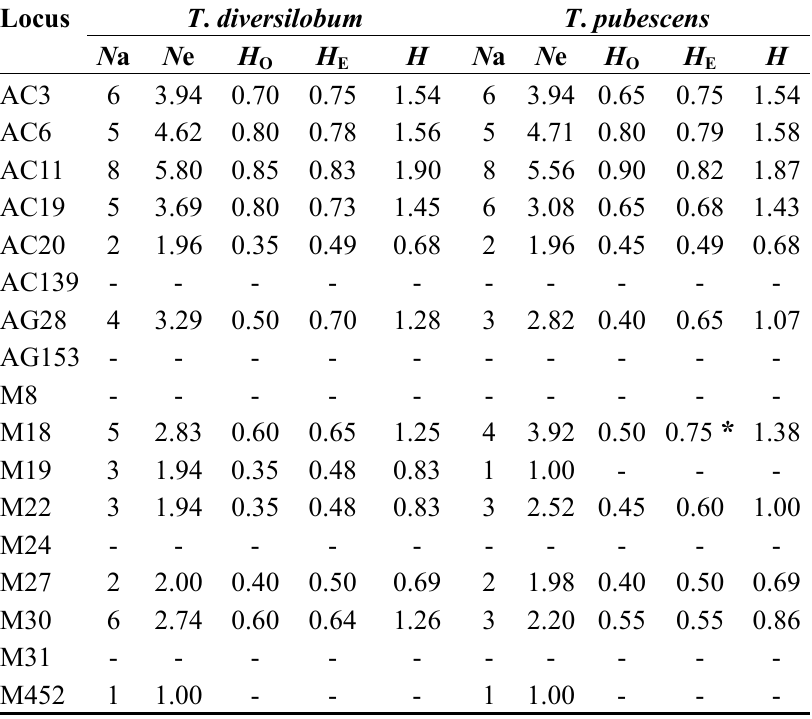
), expected heterozygosity O